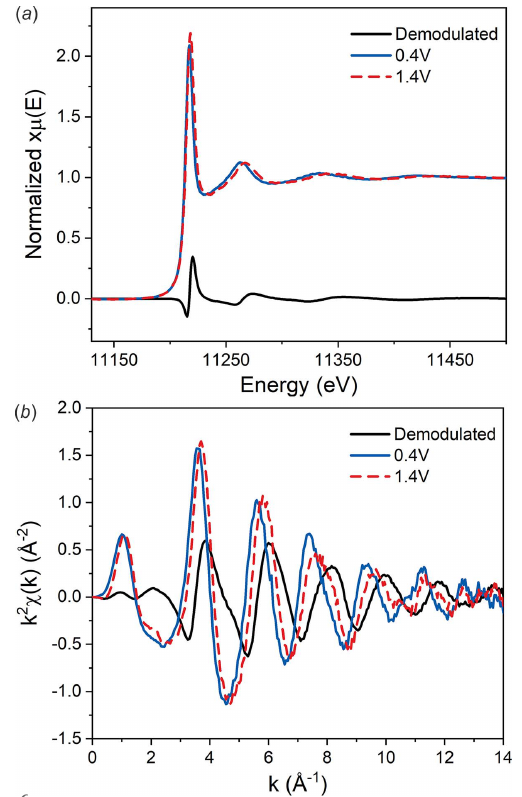
Figure 6 Comparison of the original spectra and the demodulated spectrum in E - space ( a ) and k -space ( b